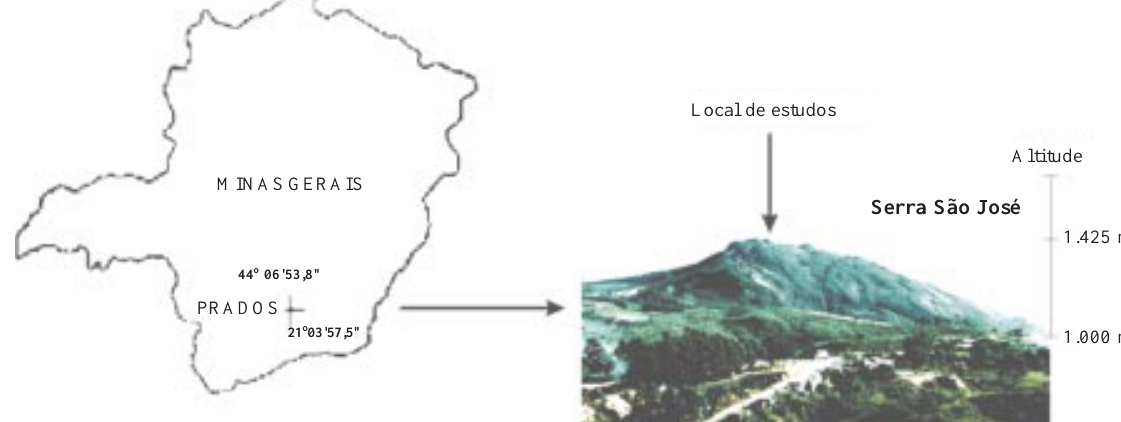
Figura 1. Localização da área dos